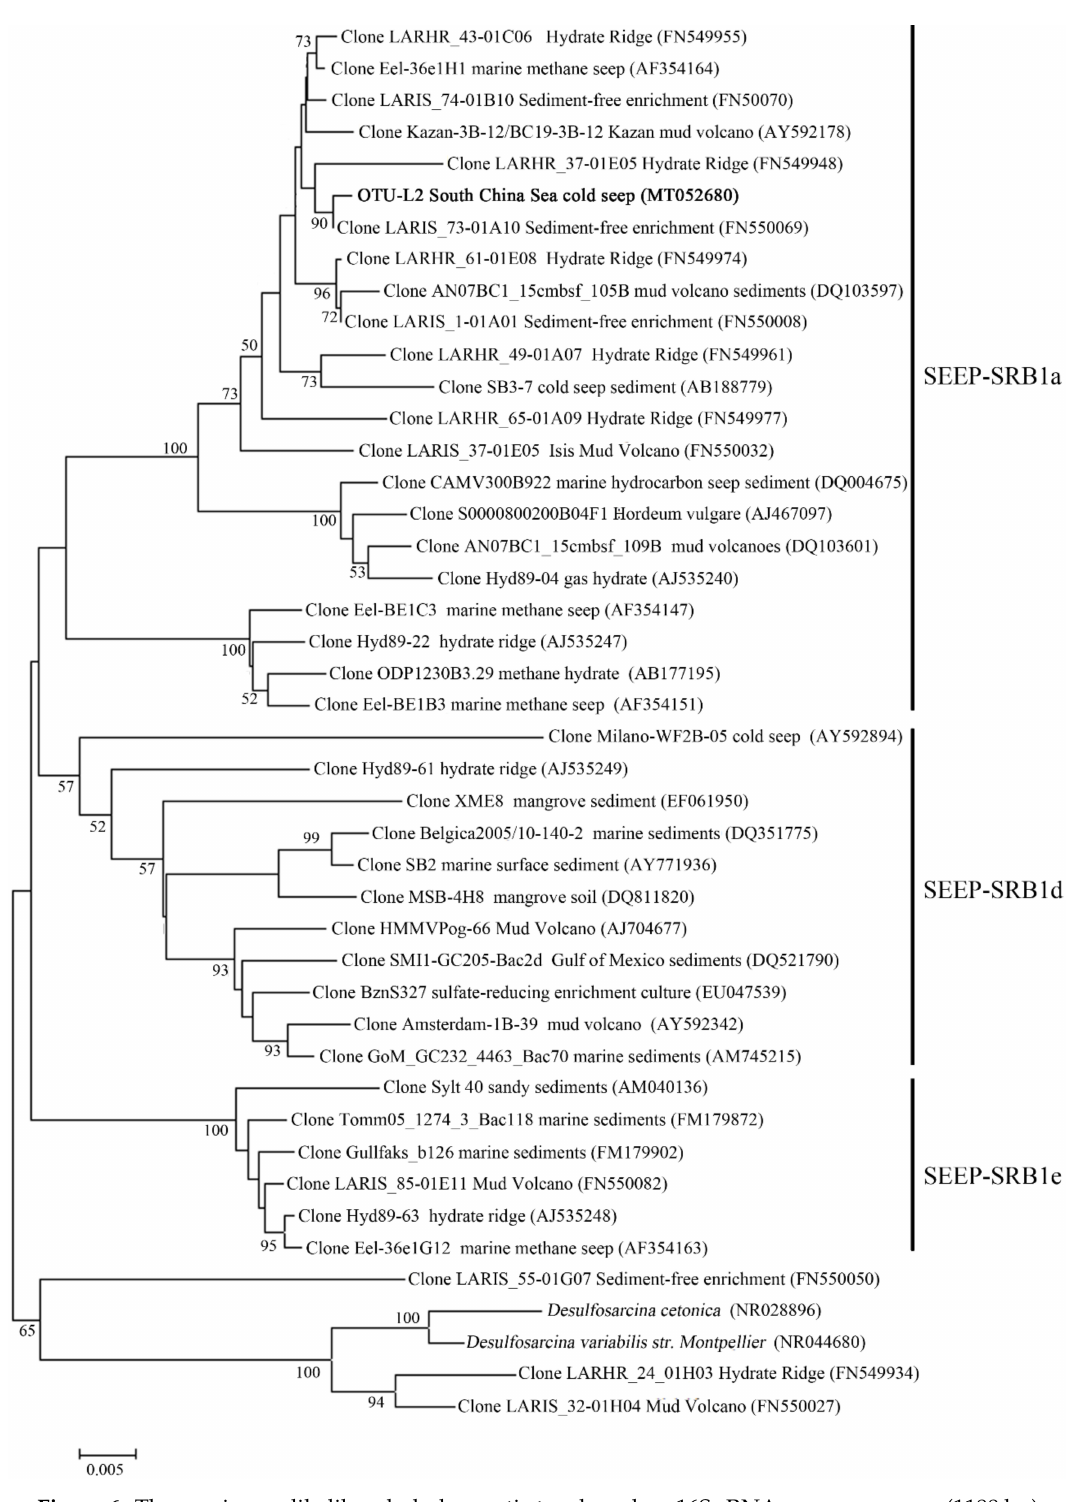
Figure 6. The maximum-likelihood phylogenetic tree based on 16S rRNA gene sequences (1188 bp) showing the position of OTU-L2 from this study. GenBank accession numbers are shown in parenthesis. Sequences within seep sulfate-reducing bacteria—1 (SEEP-SRB1) were selected according to Schreiber et al. 2010. Only bootstrap values (expressed as percentages of 1000 replications) equal or greater than 50% are shown at the branching points. Scale bar, 0.005 substitutions per nucleotide